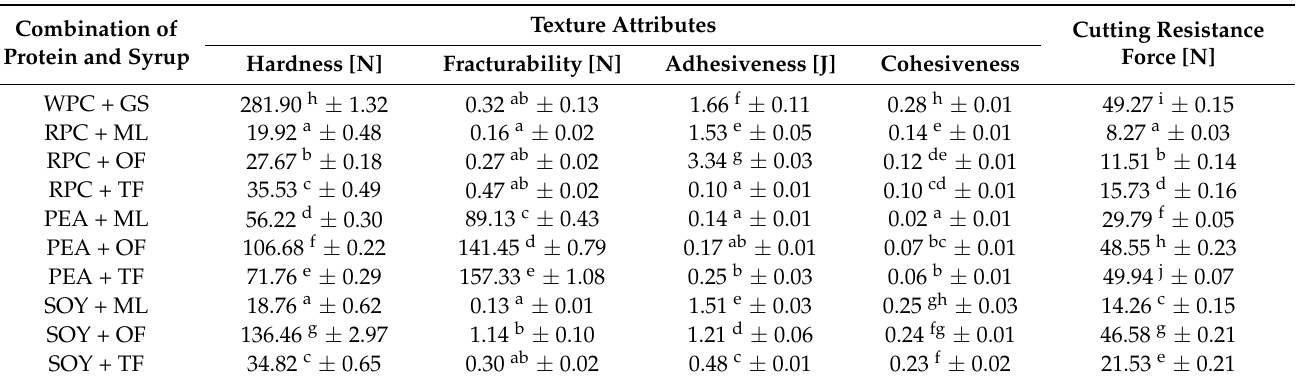
Table 1. Impact of different protein and syrup combinations on the high-protein bars texture attributes and cutting resistance.